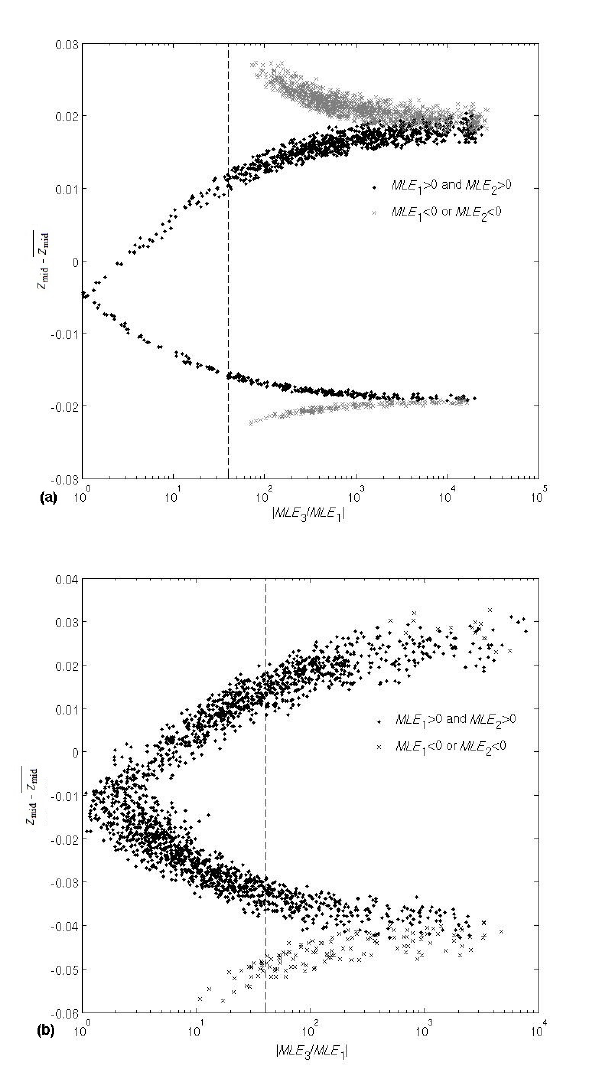
Fig. 3. (a) Illustration of the ratio | MLE 3 /MLE 1 | for the triplets with more than two solutions in Fig. 1a, using the same vertical axis; (b) the same as Fig. 3a, but for the near-swath WVC, i.e. number 41. The dashed line indicates the threshold used to separate triplets with rejected high-rank solutions (right side) from those with kept high-rank solutions (left side).